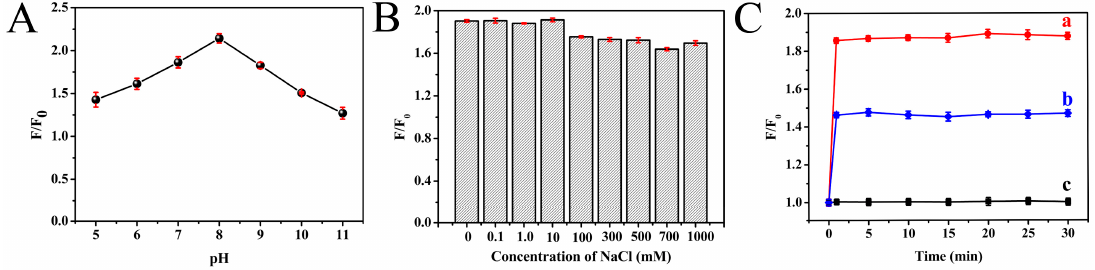
Figure 5. The effect of pH ( A ), concentration of NaCl ( B ) and incubation time ( C ) on fluorescence intensity of Au NCs upon addition of Cd 2+ ions at different concentrations (35 µ M (a); 10 µ M (b); and 0 µ M (c)), respectively.